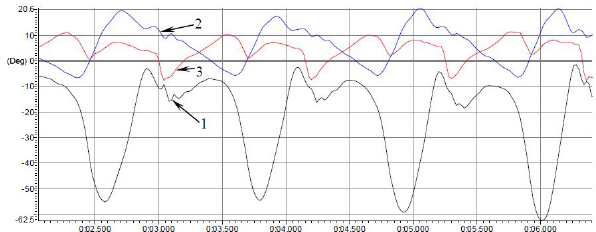
Figure 3. 1 – right knee flexion/extension; 2 – right hip flex- ion/extension; 3 – right ankle flexion/extension; Healthy human measured hip, knee and ankle joint angle, in sagittal plane, for right